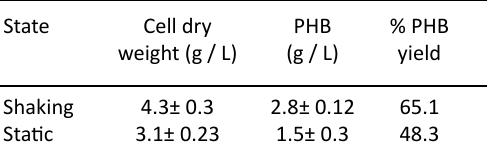
Table 4. Effect of different conditions on production of PHB by Bacillus sp.